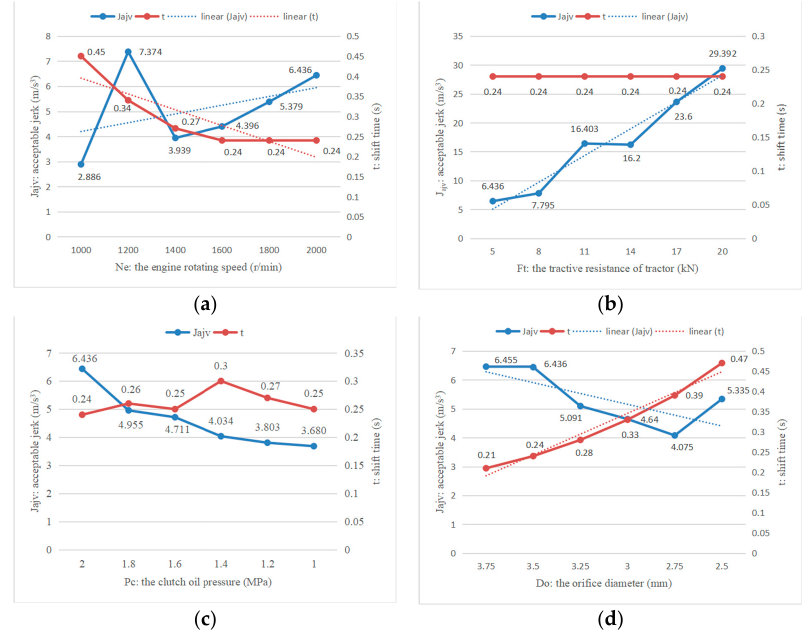
Figure 7. The test results of a single parameter. ( a ) The test results of the engine speed; ( b ) The test results of the tractive resistance of the tractor; ( c ) The test results of the clutch oil pressure; ( d ) The test results of the orifice diameter.